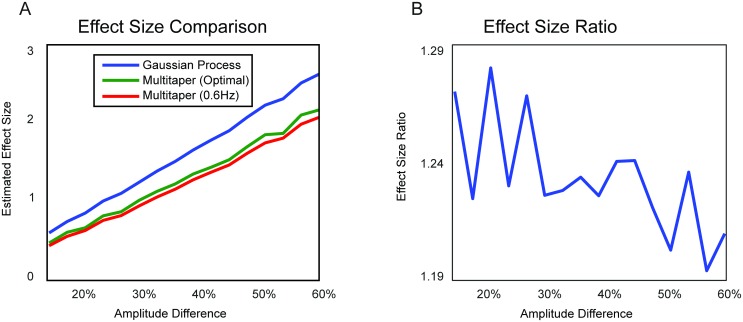
Simulation results on the estimation of modulations in oscillatory amplitude.A) Effect size of temporal GP and DPSS multitaper spectral analysis as function of mean percentage amplitude difference between simulated conditions. The parameters of the temporal GP-based decomposition (blue line) were estimated from the raw simulated time series. The spectral smoothing of the multitaper method (green line) was chosen for each to maximize the effect size. The red line is the effect size for a multitaper method with constant spectral smoothing of 0.6 Hz. B) Effect size ratio between temporal GP and (optimized) multitaper method as function of the mean amplitude difference between conditions.